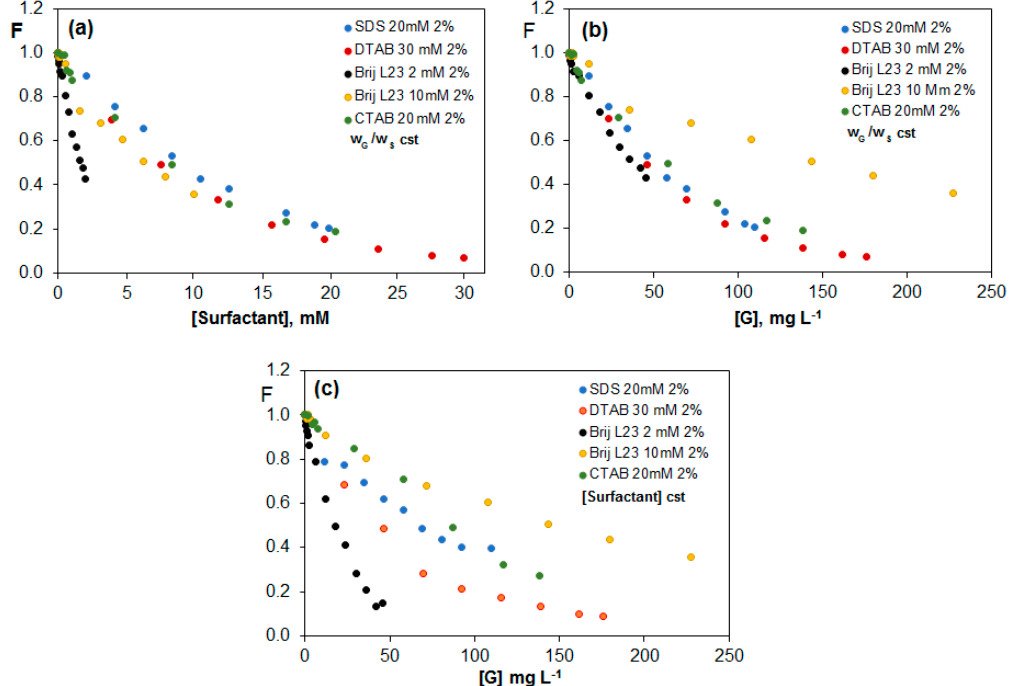
Figure 9. Comparison of the quenching effect for G (2 wt %) dispersions in the different surfactants as a function of surfactant ( a ) and G ( b , c ) concentration, for dispersions with a constant G/surfactant weight ratio ( a , b ) or constant surfactant concentration ( c ).